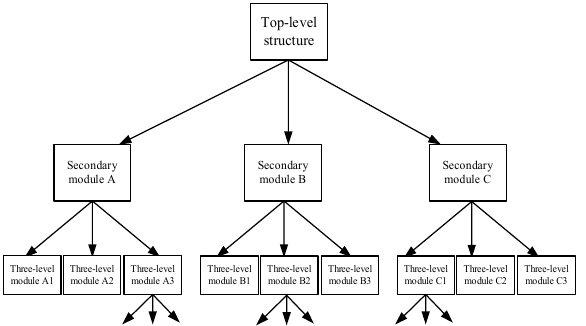
Figure 8.Remote sensing data processing design strategy based on FPGA (Geng Tian, Wenbo Xu.